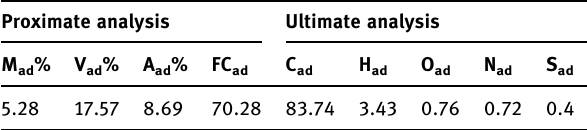
Table 1: Proximate and ultimate analyses results of semi - coke ( wt% ) Proximate analysis Ultimate